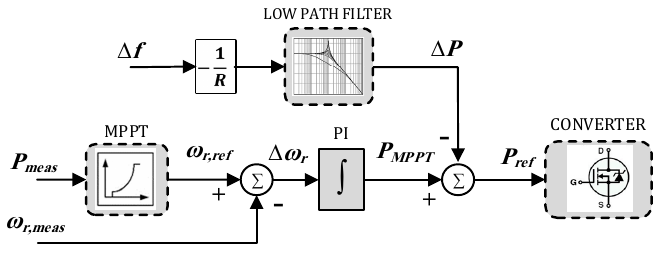
Figure 8. Droop control for VSWTs.